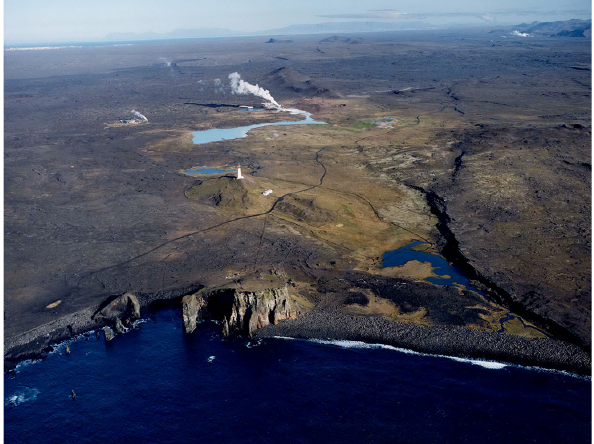
Figure 2. Oblique aerial view looking NE of the Reykjanes Penin- sula showing the location of the Reykjanes Geothermal Field (steam plume in center) and the Svartsengi Geothermal Field in the far dis- tance (upper right). Note the ridges of hyaloclastites surrounded by Holocene basaltic lava